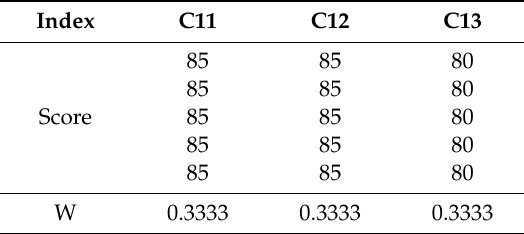
Table 6. Objective weight of the general performance.